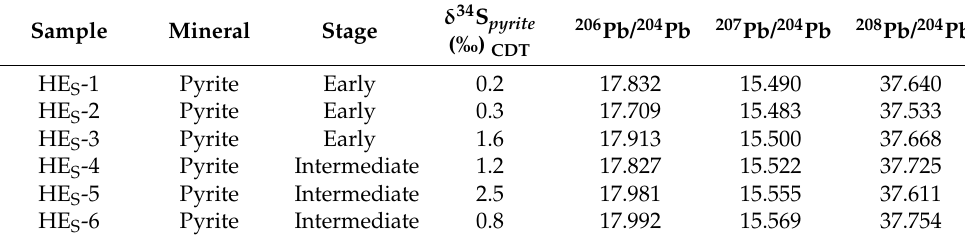
Table 3. Sulfur and Lead isotope data for pyrite of the Harla gold deposit.